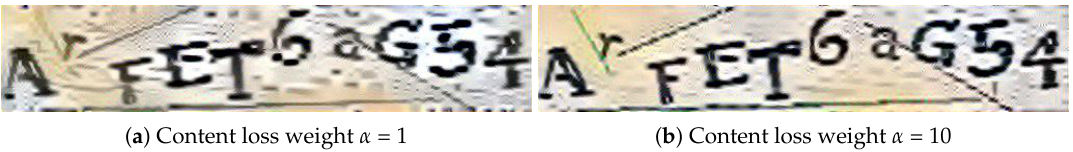
Figure 8. Examples of style-plugged CAPTCHAs according to the content loss weight α